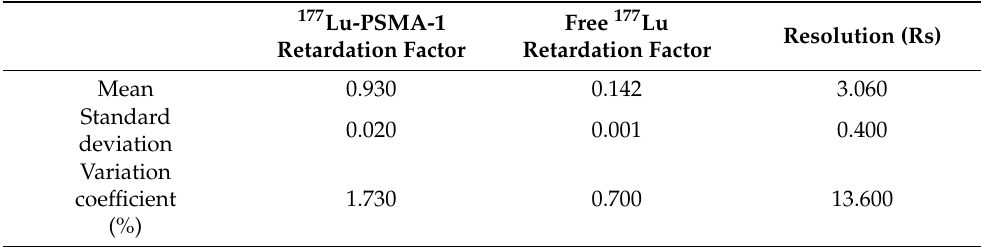
Table 2. Retardation factor and resolution in